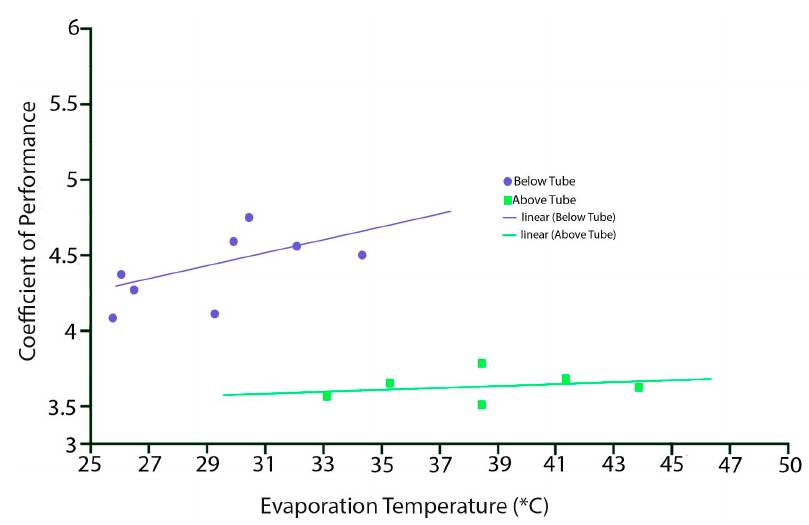
Figure 10. COP systems with variable evaporator temperature.